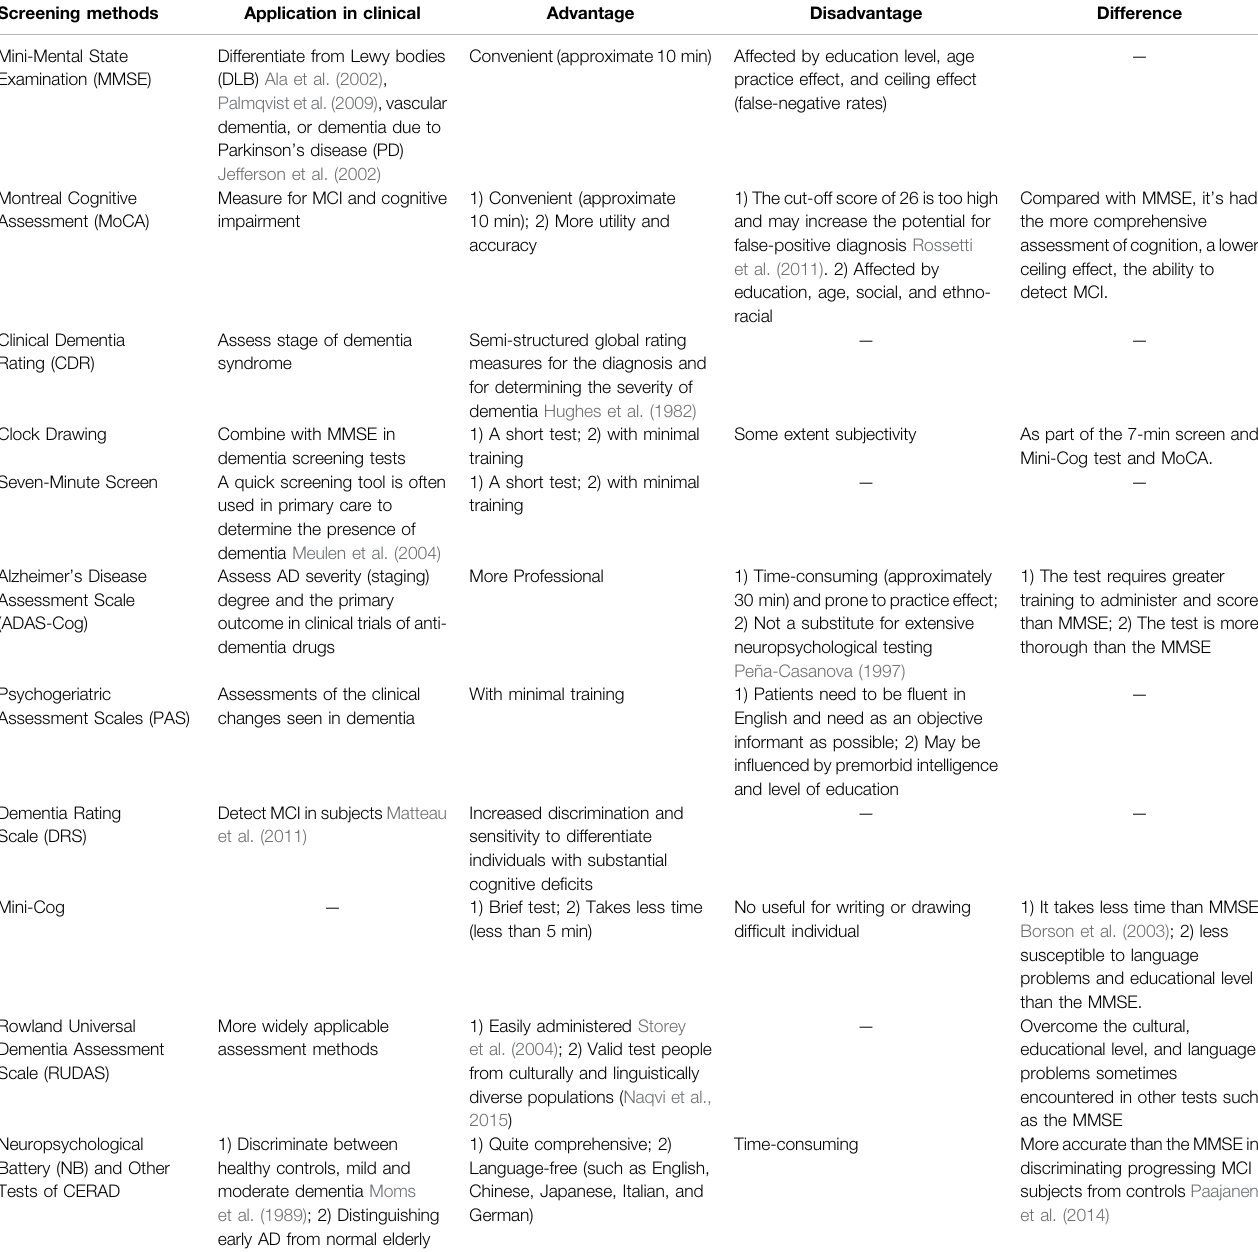
TABLE 1 | The usual assessment approaches of cognition domain and application in